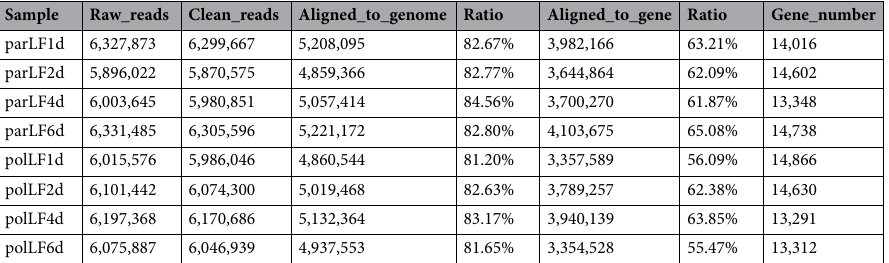
Table 1. Overview of litchi fruit